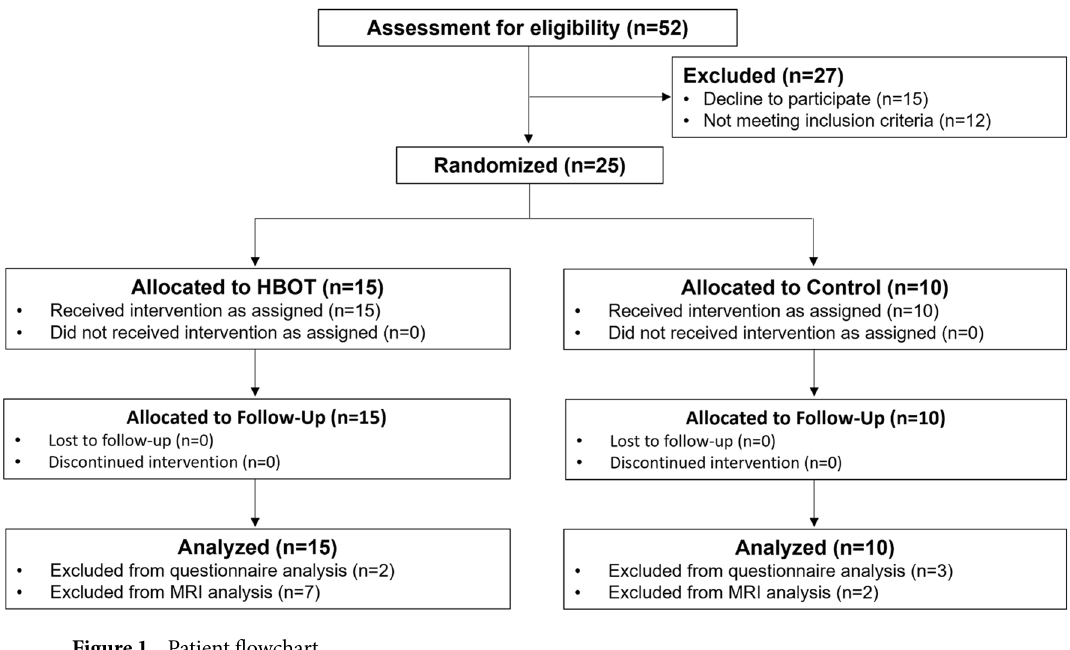
Figure 1. Patient